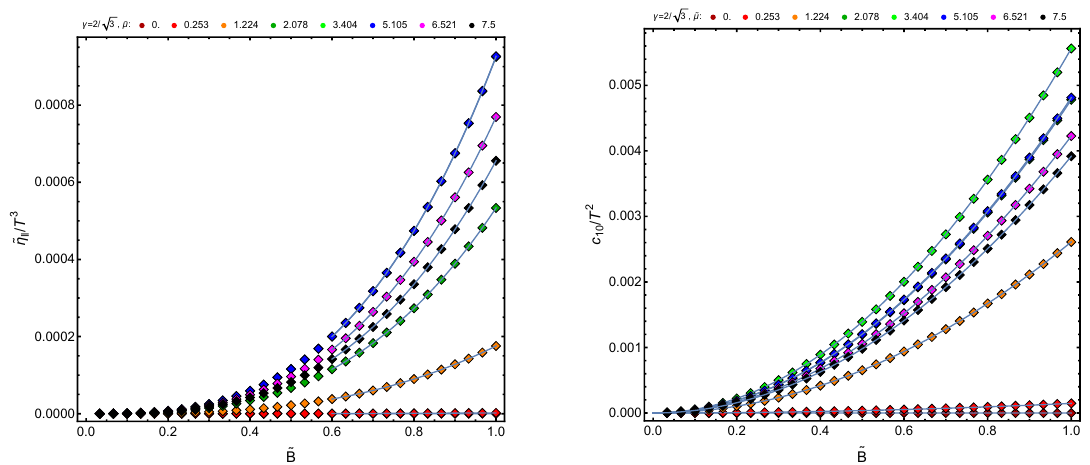
Figure 16 . Fit of our numerical data (dots) for c 10 and ˜ η